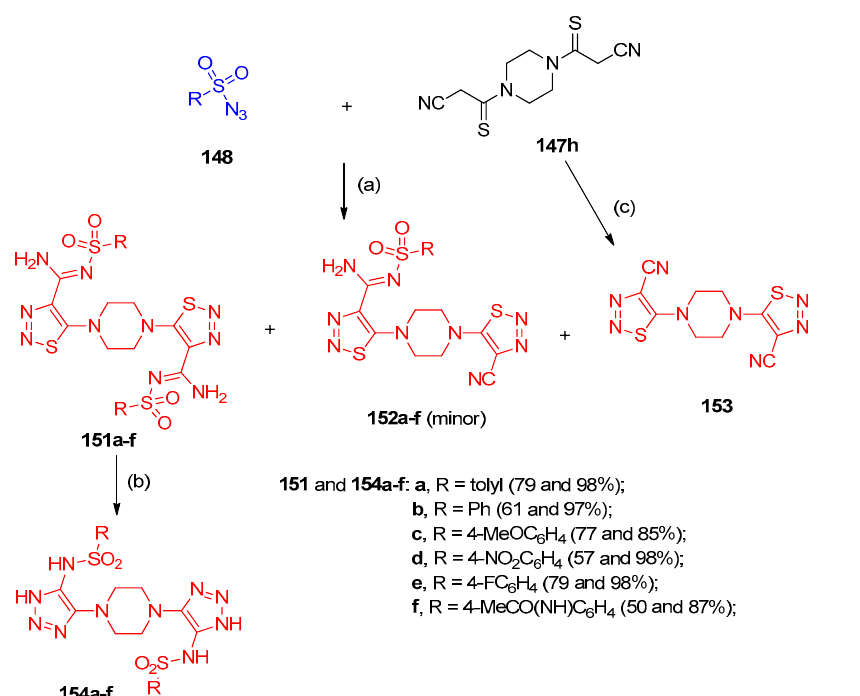
Scheme 62. Synthesis of bis-triazoles 154a – f . Reagents and conditions : (a) H 2 O, NaOH; (b) NaOMe, MeOH; (c) TsN 3 , pyridine.